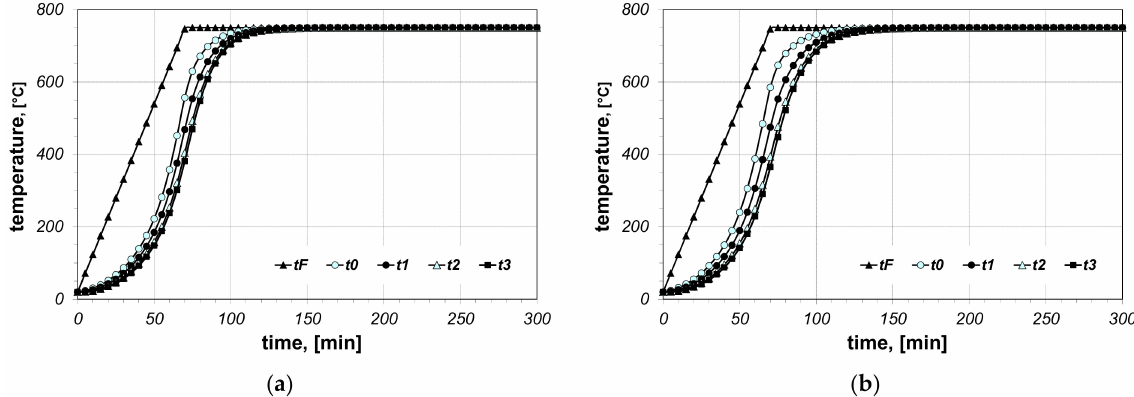
Figure 11. Calculated values of temperatures for heating of a 10 × 40 bar bundle with vertical arrangement: ( a ) results obtained for R ct-min , ( b ) results obtained for R ct-max